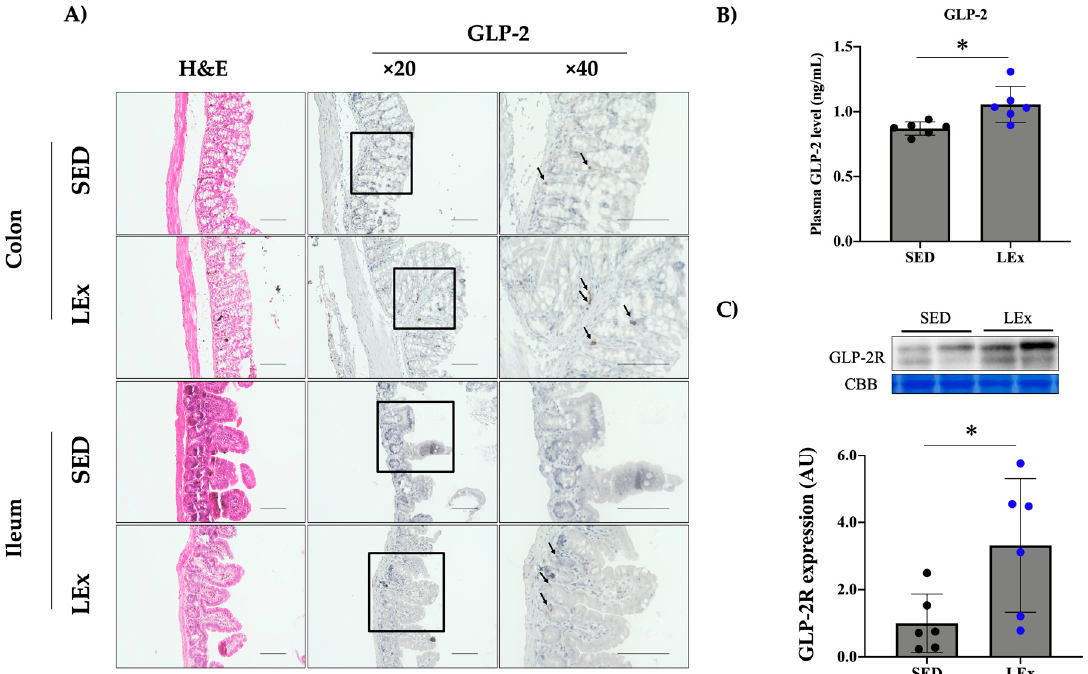
Figure 2. Effects of acute exercise on GLP-2 and GLP – 2R. ( A ) Hematoxylin and eosin staining and GLP-2 immunohisto- chemistry. Scale bar, 100 μ m. Black arrows indicate GLP-2. ( B ) Levels of plasma GLP-2. ( C ) Expression of GLP-2R in the jejunum. GLP-2: glucagon-like peptide-2, GLP-2R: glucagon-like peptide-2 receptor. CBB: Coomassie brilliant blue stain. To ensure equal protein loading across lanes, membranes were stained with CBB. The CBB bands represent the 35–48 kDa region where various internal controls are present. SED: sedentary group ( n = 6). LEx: low-intensity exercise group ( n = 6). * p < 0.05.